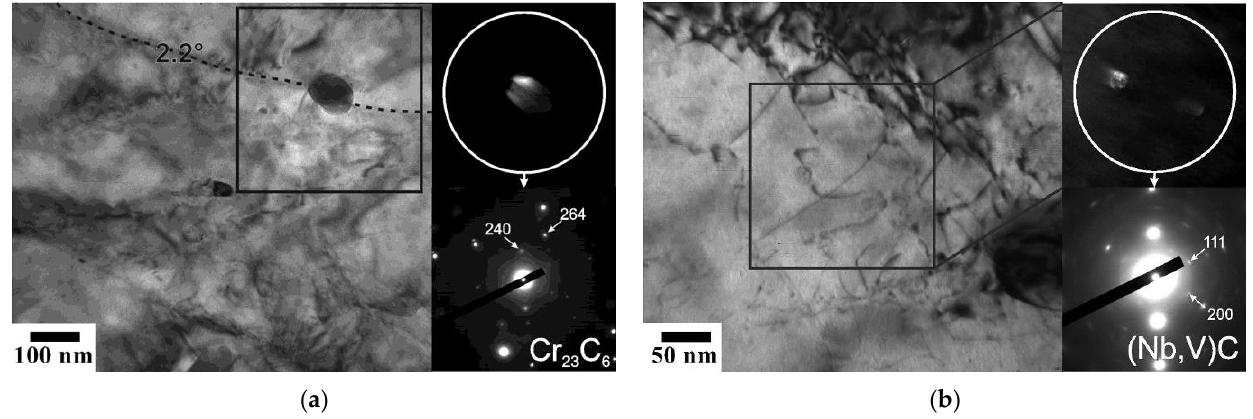
Figure 3. Particles of Cr 23 C 6 ( a ) and (V,Nb)C ( b ) in an HSLA steel tempformed at 923 K. The number in ( a ) indicates the sub-boundary misorientation in degrees.